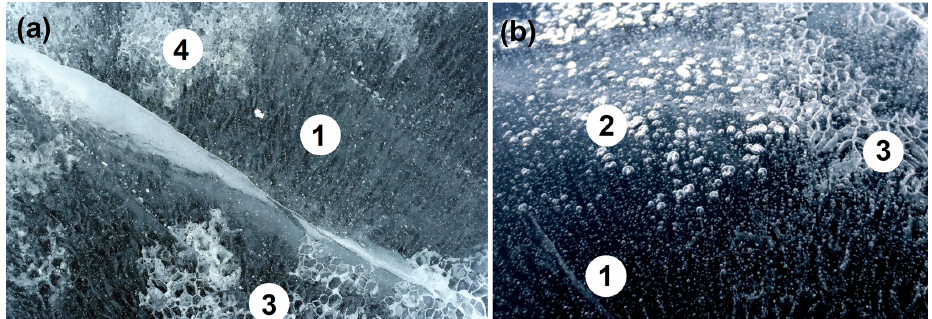
Figure 8. Different manifestations of ice metamorphism on the ice cover surface. (a) Southern Baikal, 10 April 2006 (photo: E. Petrov); (b) middle Baikal, 3 April 2014 (photo A. Kouraev). Photo shots were taken while standing on ice (about 1.5m height). 1 – vertical lines of air bubbles; 2 – large bubbles just below ice surface; 3 – air channels showing boundaries of columnar ice crystals, and horizontal size of these crystals is about 2–4cm; 4 – similar to 3, but upper central parts of columnar ice are also